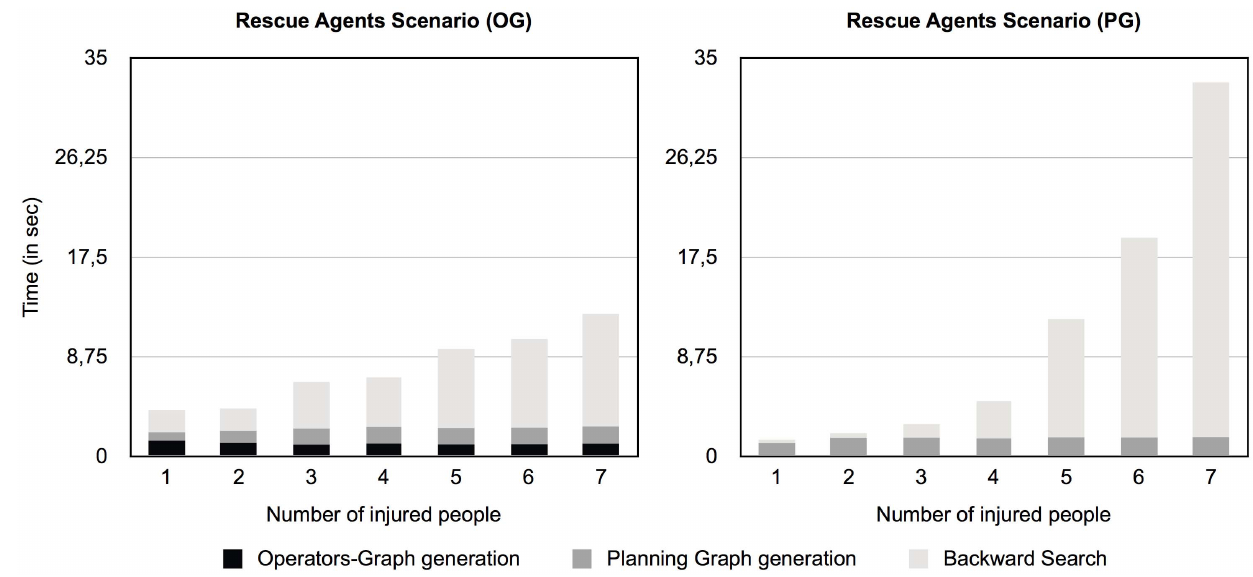
Figure 2. Comparison between algorithms in the RescueAgents scenario. Breakdown and comparison of activities between Operators- graph-based Distributed Graphplan (left panel) and Distributed Graphplan (right panel) in the Rescue Agents scenario.